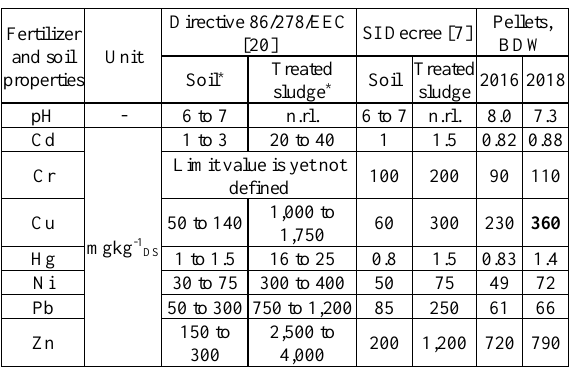
Table 10. Evaluation of pellets for direct use in agriculture - comparison of limit values